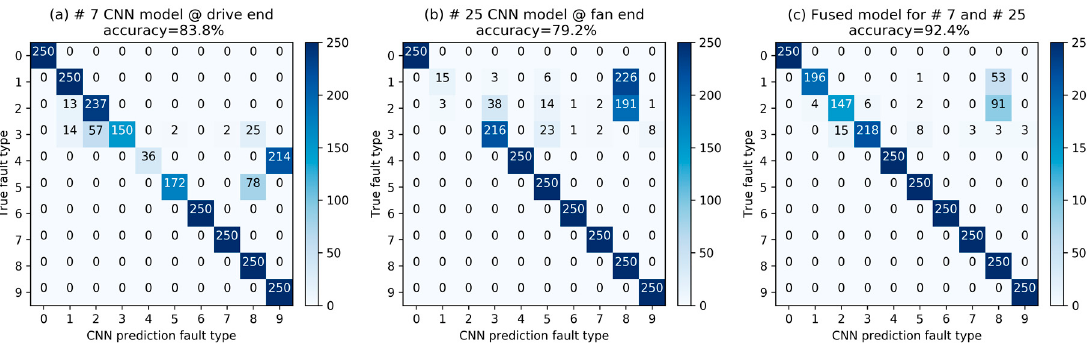
Figure 9. Information fusion between drive-end and fan-end predictions: ( a ) confusion matrix of #7 CNN model trained with drive-end signal (See Table 5) for C → A test; ( b ) confusion matrix of #25 CNN model trained with fan-end signal (See Table 5) for C → A test; and ( c ) confusion matrix of fused model for #7 and #25 for C → A test.